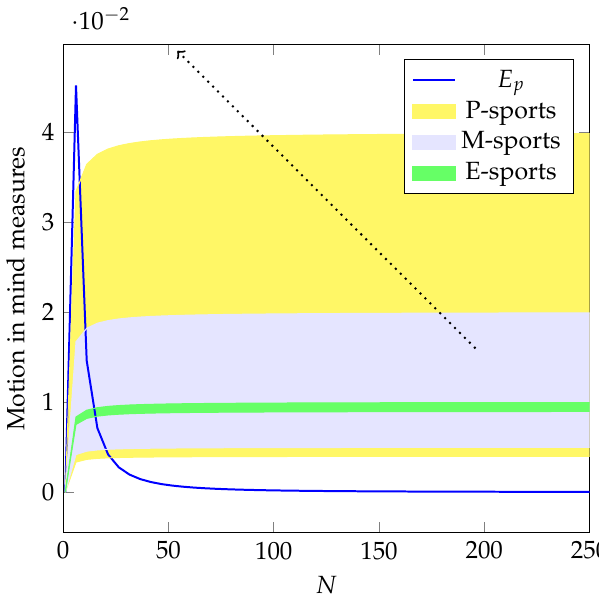
Figure 1. The convergence of p-sports, m-sports, and e-sports based on the a indicators, relative to the physics in mind measures.